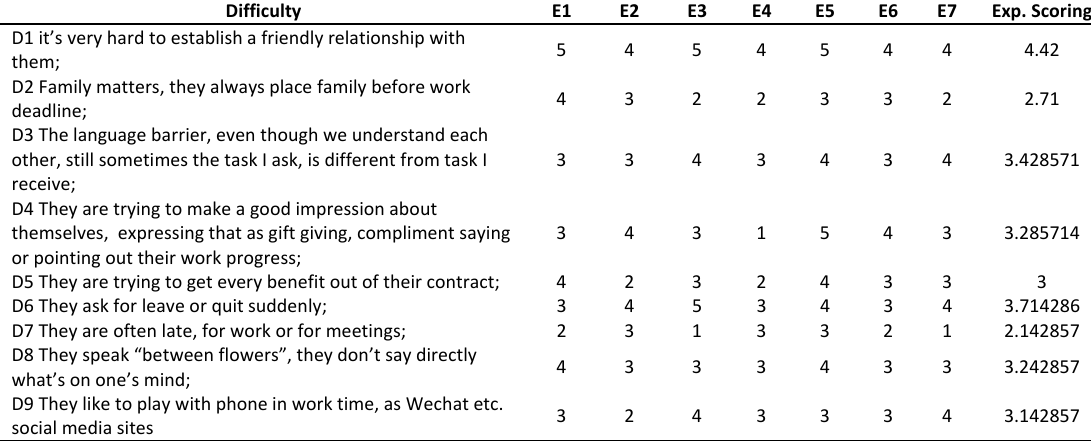
Table 3: DMs Averaged Matrix